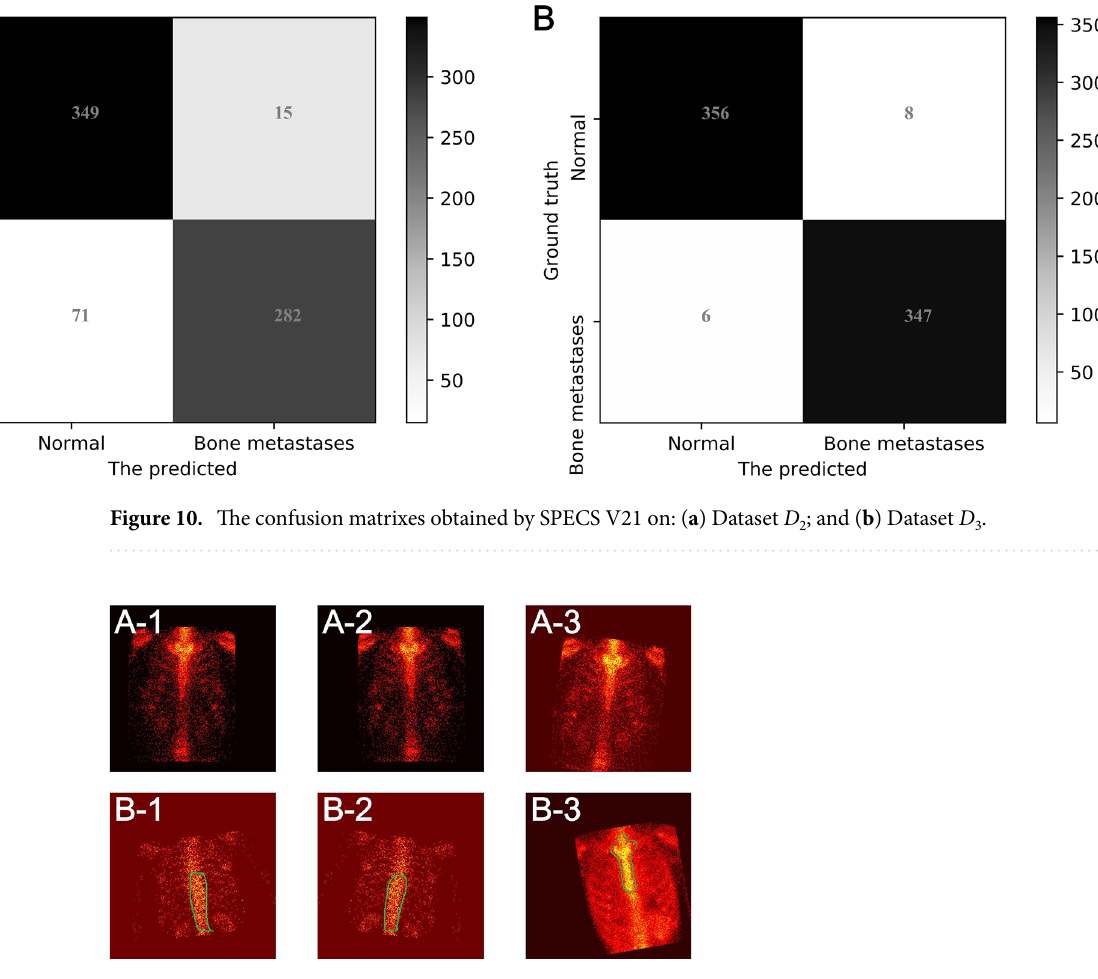
Figure 11. A demonstration of misclassified thoracic SPECT bone images. ( a ) Misclassified normal images as the metastasized; and ( b ) misclassified metastasized images as the